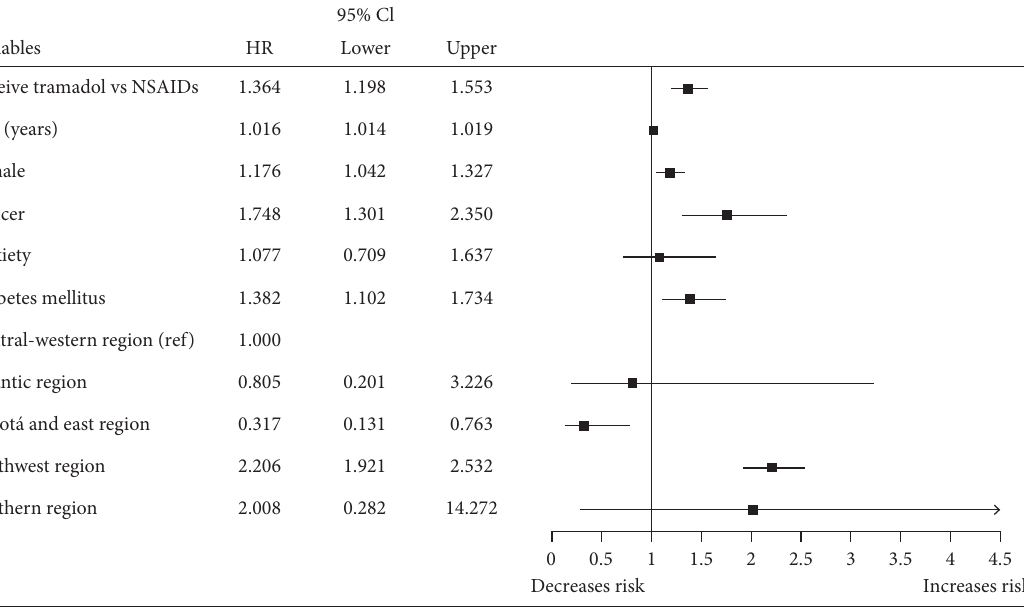
Figure 2: Cox regression of tramadol versus nonsteroidal anti-inflammatory drugs on the probability of receiving a new opioid up to 12 months of follow-up after being treated in emergency departments of five clinics in Colombia.